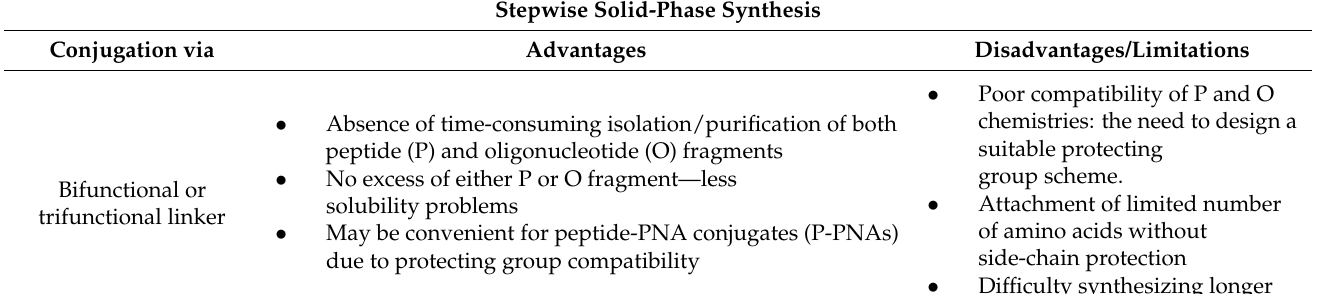
Table 2. Main approaches to the synthesis of POCs, and their advantages and limitations. Stepwise Solid-Phase